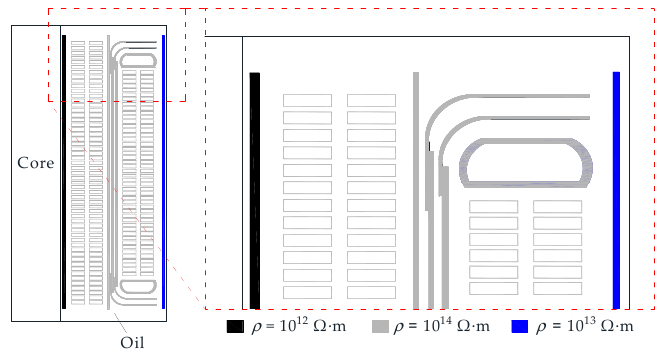
Figure 11. Setting of paper resistivity values and their corresponding location. Table 2. Setting of paper resistivity values.